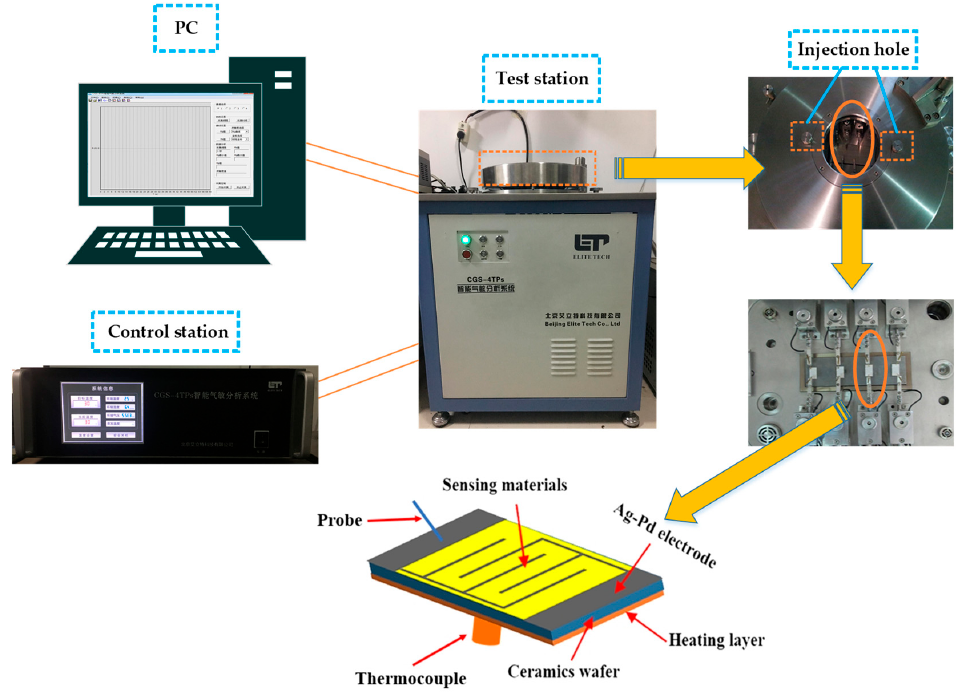
Figure 1. The schematic diagram of the gas sensing analysis system and the composition of a gas sensor.